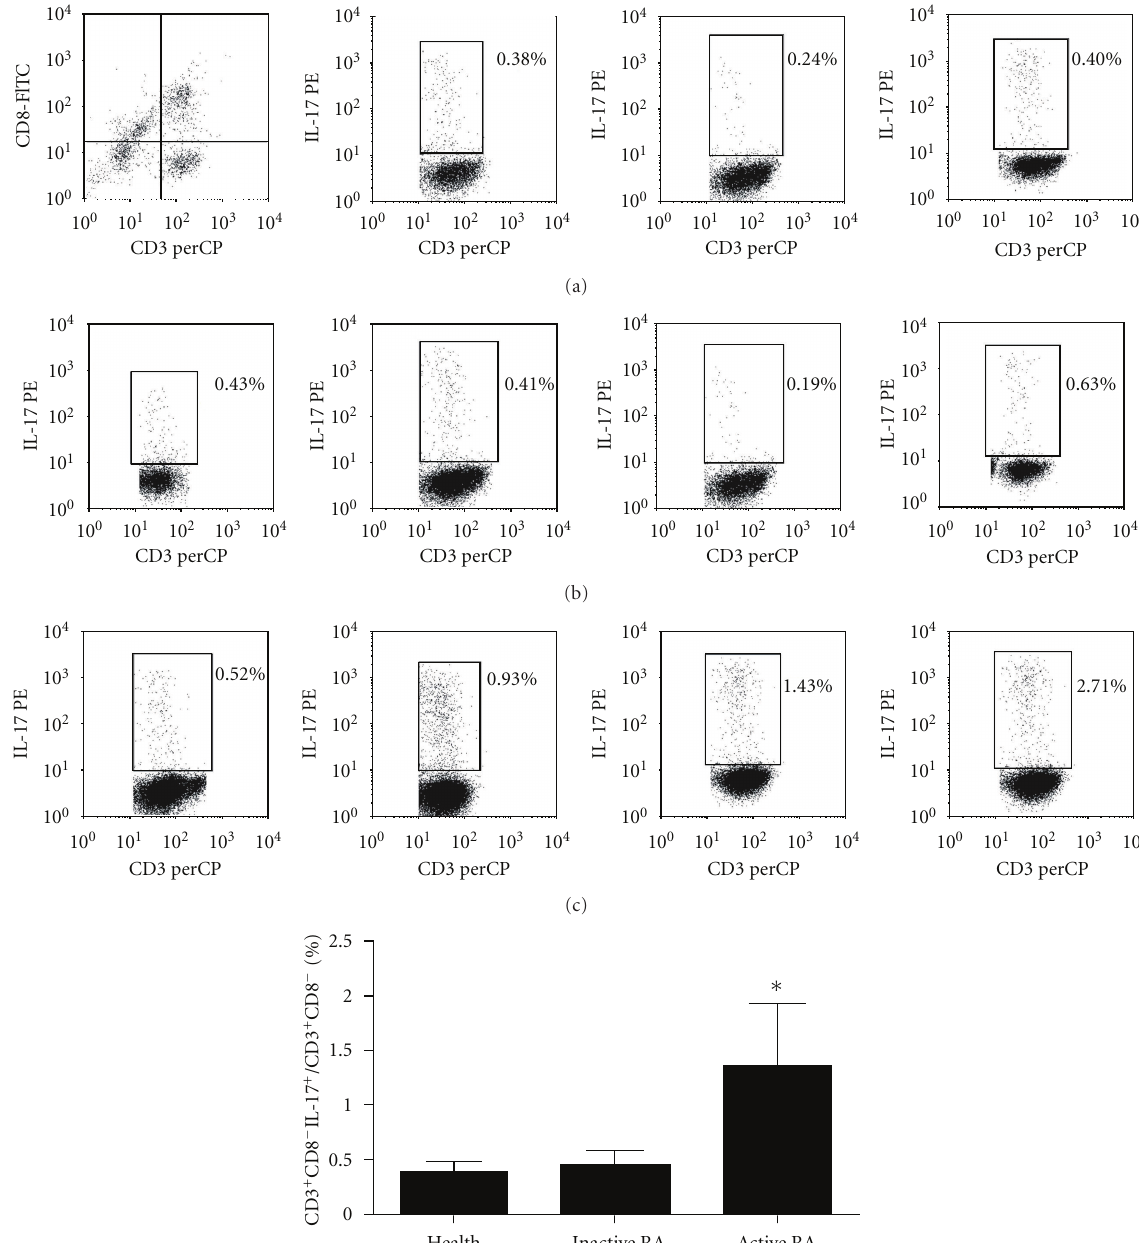
Figure 3: FACS analyzed the CD3 + CD8 − IL-17 + cell ratio in RA patient The PBMCs were isolated by standard Ficoll-Hypaque density centrifugation. The cells were stained by anti-CD3-PE-cy5, anti-CD8-FITC, and anti-IL-17-PE. (a) First figure presented CD3 + CD8 − T cells were considered CD4 + T cells in region RL, and the other three were presented healthy controls. (b) Representative IL-17 expression in CD3 + CD8 − T subsets from RA patients in inactive phase. (c) Representative IL-17 expression in CD3 + CD8 − T subsets from RA patients in active phase. (d) The results were shown as means ± SD. ∗ P < 0 . 05 compared with the control group.